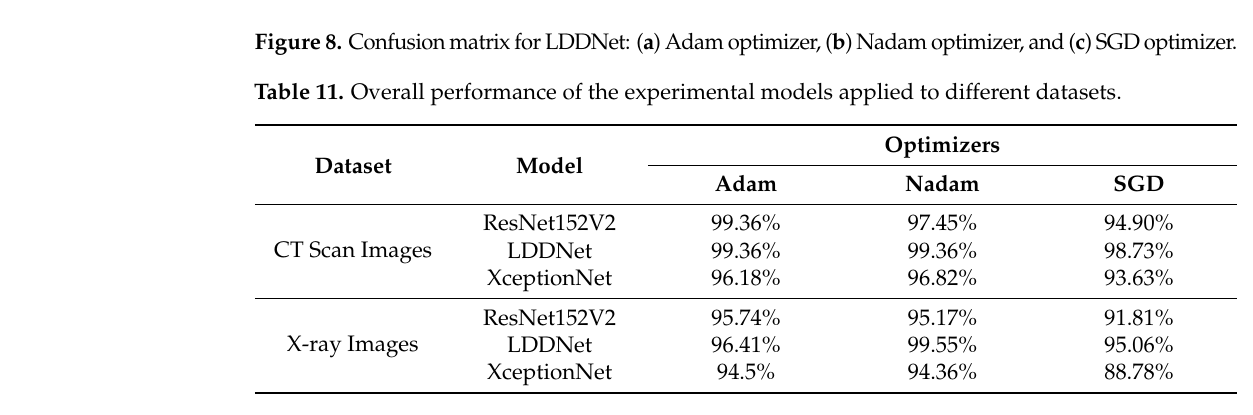
( c ) Figure 9. ROC curve for LDDNet: ( a ) Adam optimizer, ( b ) Nadam optimizer, and ( c ) SGD optimizer.